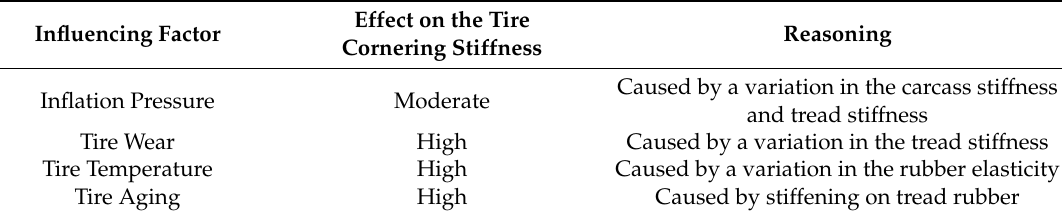
Table 2. Factors affecting the tire cornering stiffness.